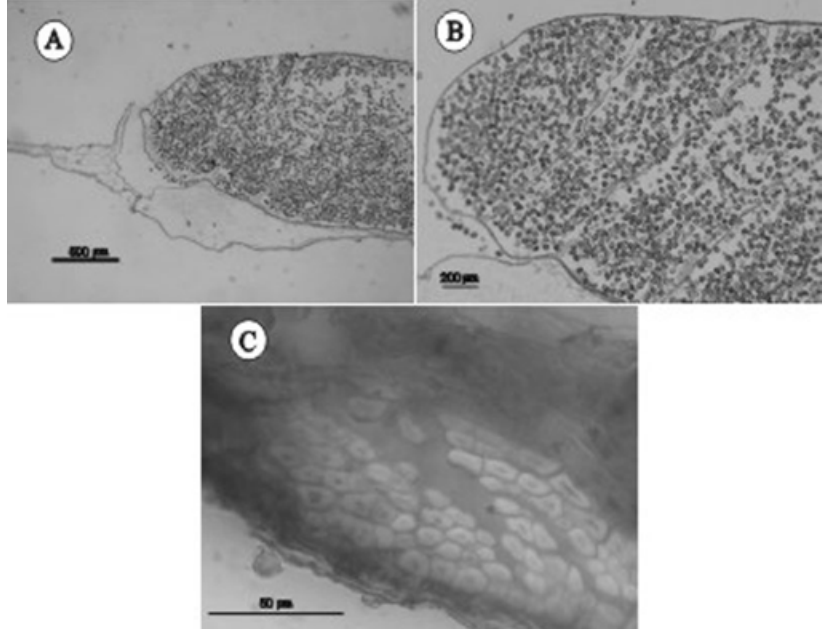
Fig. 4 – Isoetes pedersenii . A-C. Cross sections observed with LM. A – Cross section of the microsporangium, with microspores inside. B – Detail of the microsporangium where trabeculae can be seen. C – Micrograph of the sclerenchymatic beads of the microphyll. ( Pedersen 8105 ,